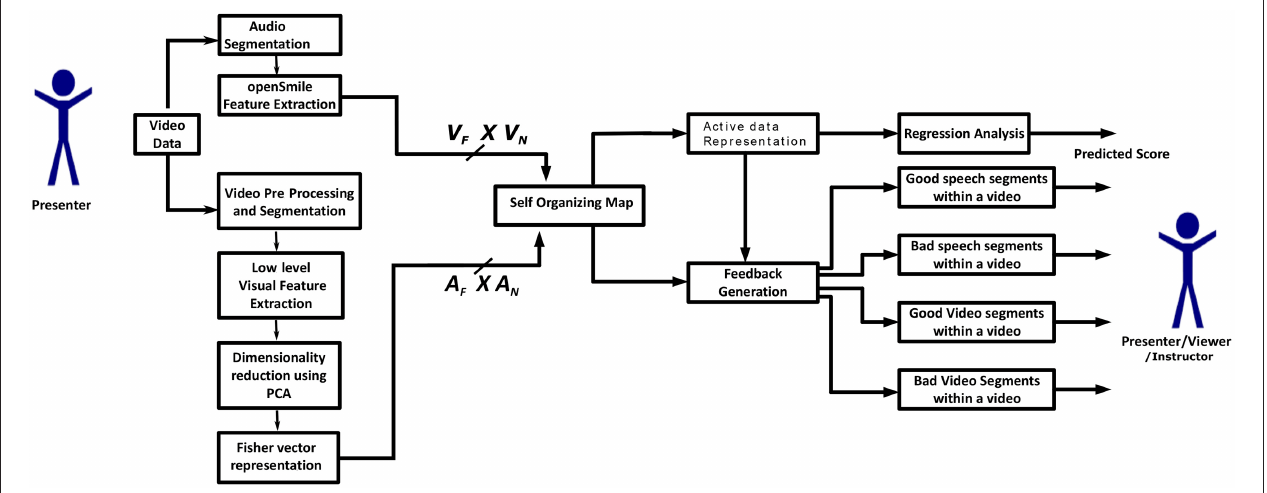
FIGURE 1 | System architecture: A N is the total number of audio segments ( A N = 7,573), A F is the total number of audio features ( A F = 587), V N is the total number of video segments ( V N = 58,541) and V F is the total number of visual features ( V F = 4,608) in the MLA